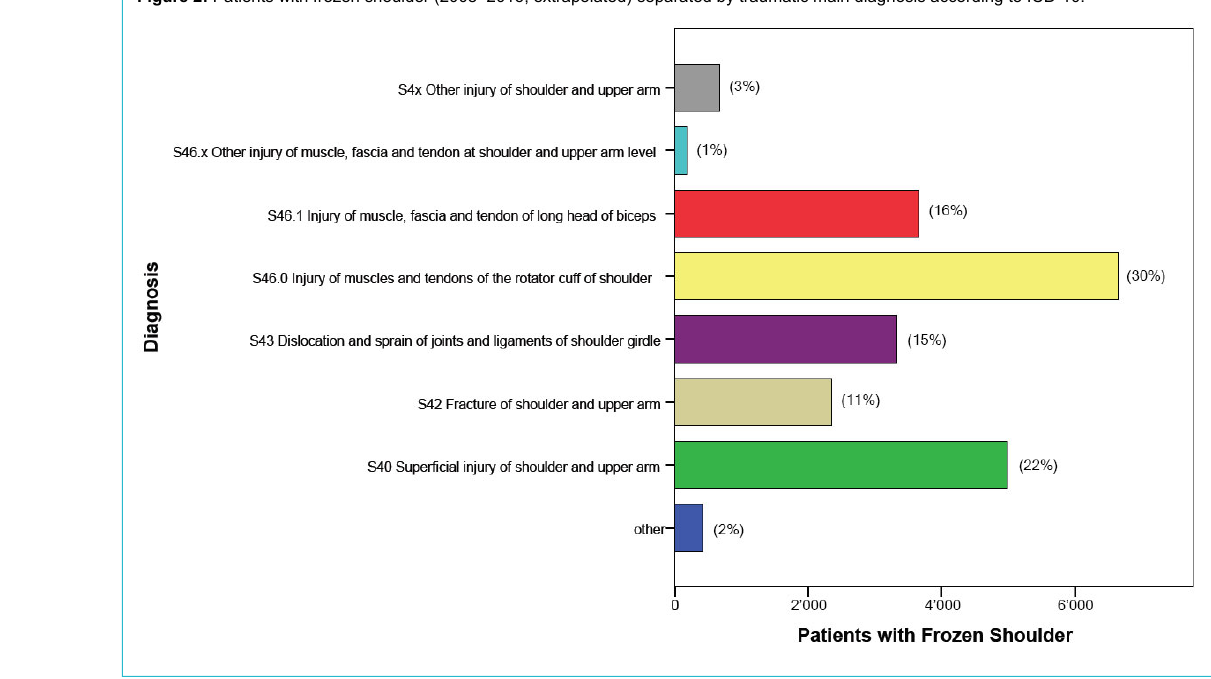
Figure 2: Patients with frozen shoulder (2008–2015, extrapolated) separated by traumatic main diagnosis according to